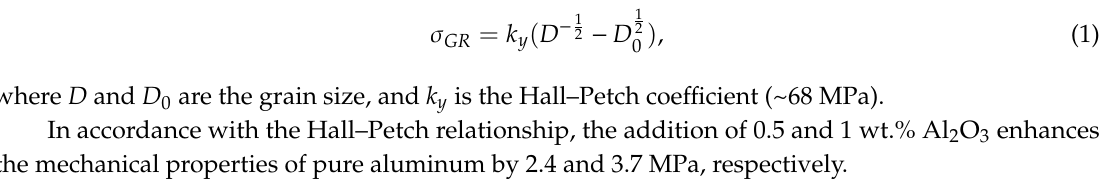
Figure 5. The dependencies of ( a ) the yield stress (YS) and ( b ) the ultimate tensile stress (UTS) depending on the Al 2 O 3 nanoparticle concentration in the 1100 aluminum alloy.